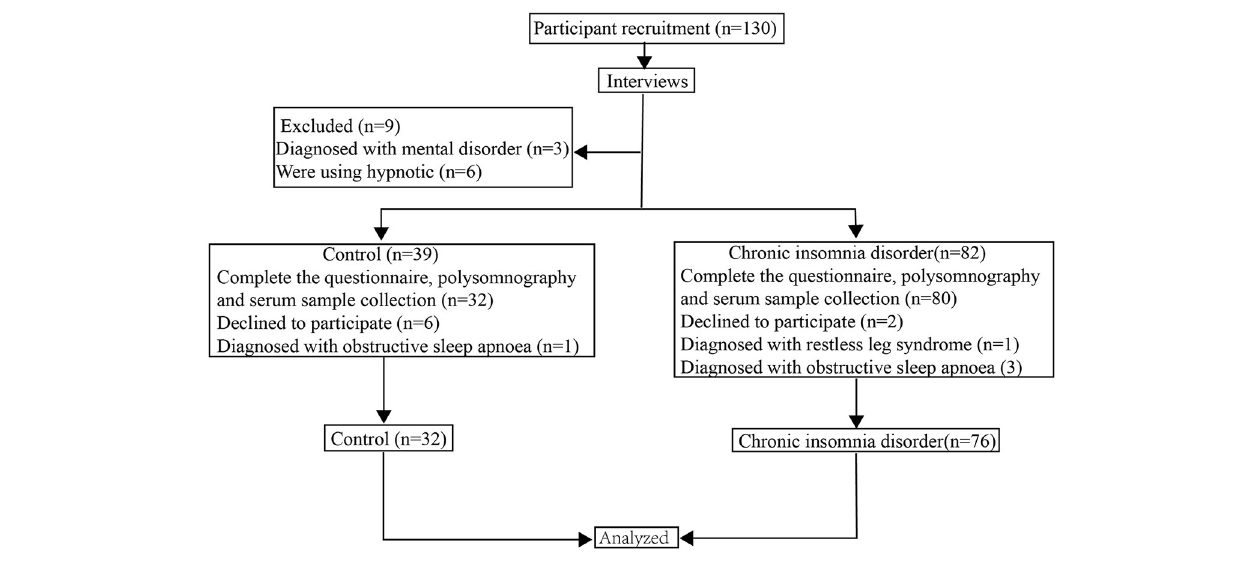
FIGURE 1 | The flowchart of the study participants.